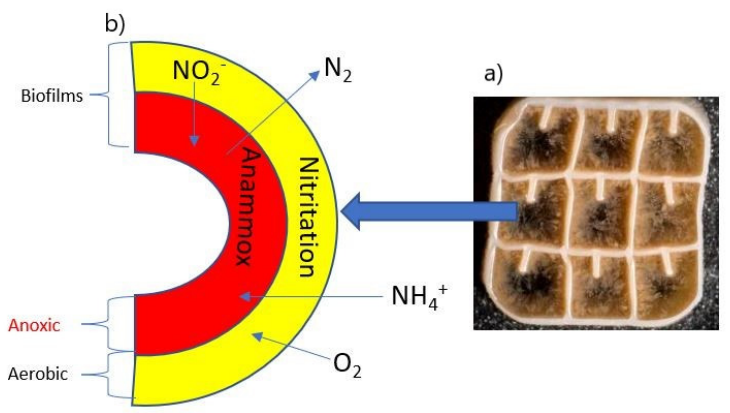
Figure 1. Simultaneous partial nitritation and anammox process in the biofilm: ( a ) figure of biocarrier along with biofilm; ( b ) different biochemical process in different layer of biofilm [3] .